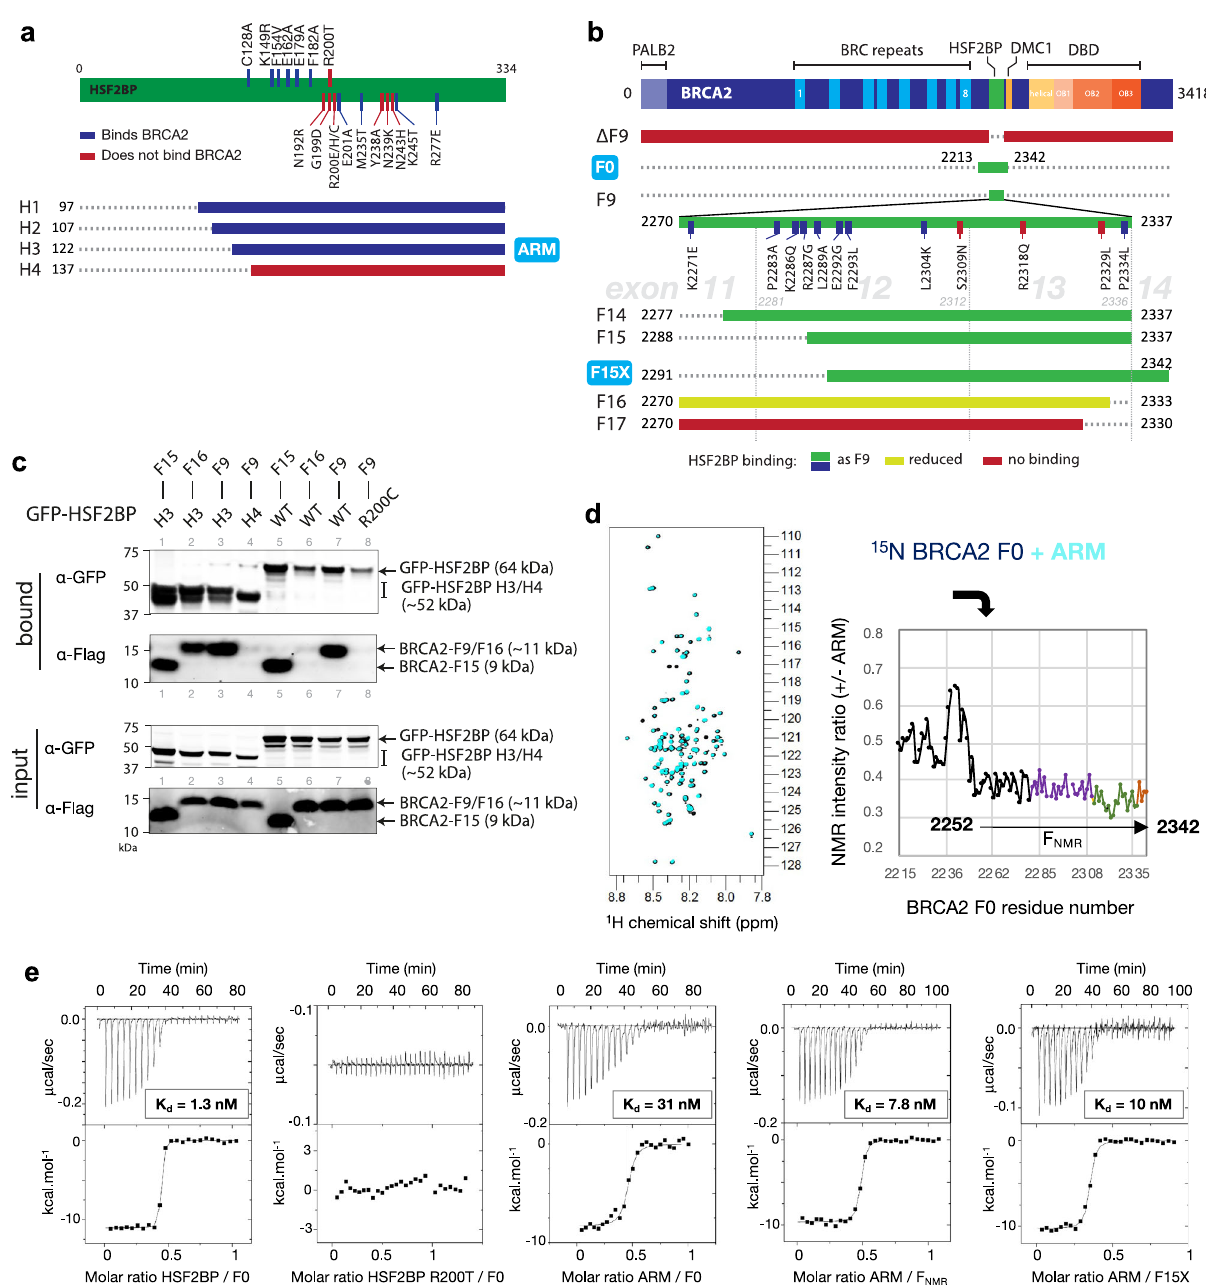
Fig. 1 The ARM domain of HSF2BP binds with a nanomolar af fi nity to a 52 aa BRCA2 peptide. a Schematic depiction of the truncation and substitution variants of HSF2BP used in this study. Substitutions tested previously are mapped above the bar, whereas those tested in this study are indicated below the bar. Truncation variants are colored based on their ability to bind BRCA2 peptides. b Schematic depiction of BRCA2 fragments and variants used in the study. Full- length BRCA2 is shown at the top with key domains indicated. Location of the fragment F9 identi fi ed previously and its truncations tested here are shown, with colors indicating the ability to bind HSF2BP. Fragments produced as recombinant proteins are indicated with blue labels. c Coimmunoprecipitation of GFP- HSF2BP (full-length wild-type (WT) or R200C variant, and fragments H3 (ARM) and H4) and indicated Flag-tagged BRCA2 variants. Proteins were transiently produced in HEK293T cells. d NMR characterization of BRCA2 residues involved in binding to the Armadillo domain of HSF2BP (ARM). 2D 1 H- 15 N HSQC spectra were recorded at 950MHz and 283K on the 15 N-labeled BRCA2 fragment F0 (S2213-Q2342), either free (100 μ M; dark blue) or in the presence of the unlabeled ARM domain (1:1 ratio; cyan). Ratios of peak intensities in the two conditions revealed that a set of peaks, corresponding to BRCA2 fragment F NMR (S2252-Q2342), decreased by more than 60% after the addition of ARM. The points and curve fragments in purple, green, and brown correspond to residues encoded by exon 12, 13, and 14 of BRCA2, respectively. e ITC curves that reveal how either HSF2BP or its ARM domain (in the instrument cell) interacts with the BRCA2 fragment F0, F NMR, and F15X (N2291-Q2342) (in the instrument syringe). The dissociation constants (K d ) are indicated. All experiments were duplicated, and the dissociation constants, stoichiometry, and thermodynamics parameters of each experiment are recapitulated in Table 1.